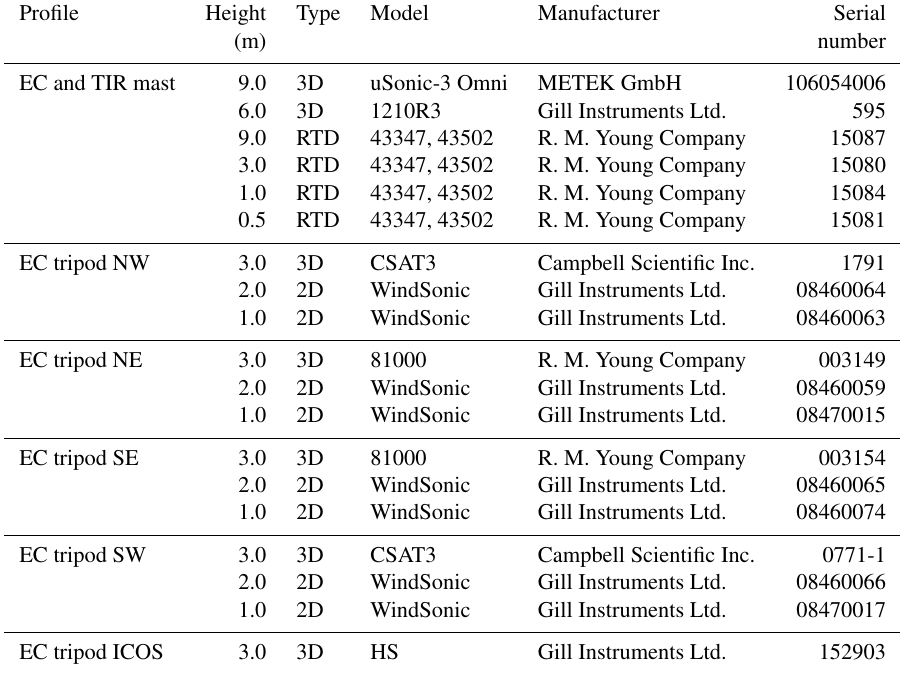
Table 1. Overview of profile instruments. The two-axis and three-axis ultrasonic anemometer are referred to as 2D and 3D, respectively. Profile Height Type Model Manufacturer Serial (m) number EC and TIR mast 9.0 3D uSonic-3 Omni METEK